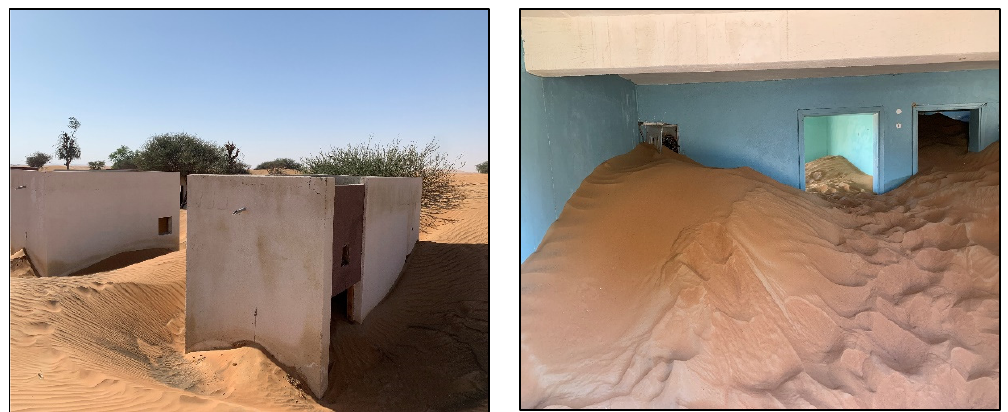
Figure 11. Sand accumulations between two buildings ( left ) and inside a dwelling ( right ) in Al- Madam, UAE (photos: M.